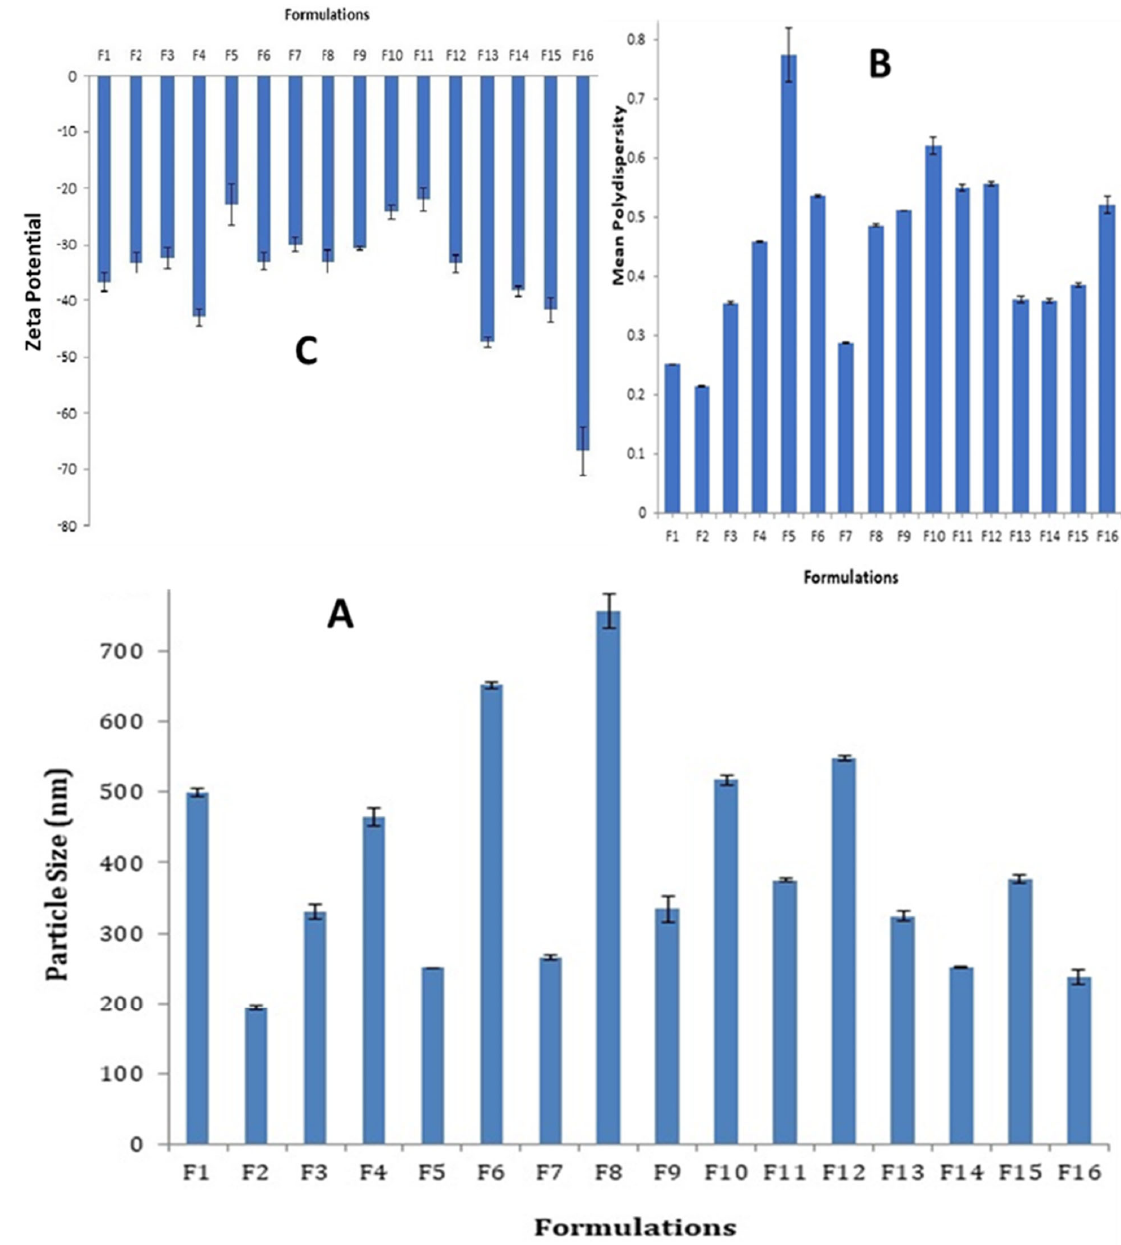
Figure 1. Particle sizes, size distribution, and zeta potentials of all SLN formulations: ( A ) Histogram of the mean particle sizes; ( B ) Histogram of the mean polydispersity indices; ( C ) Histogram of mean zeta potentials.